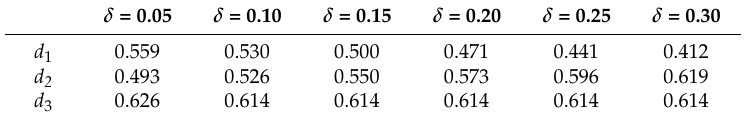
Table 5. Changes of desirability function values according to the rate of relaxation ( h = 2). δ =